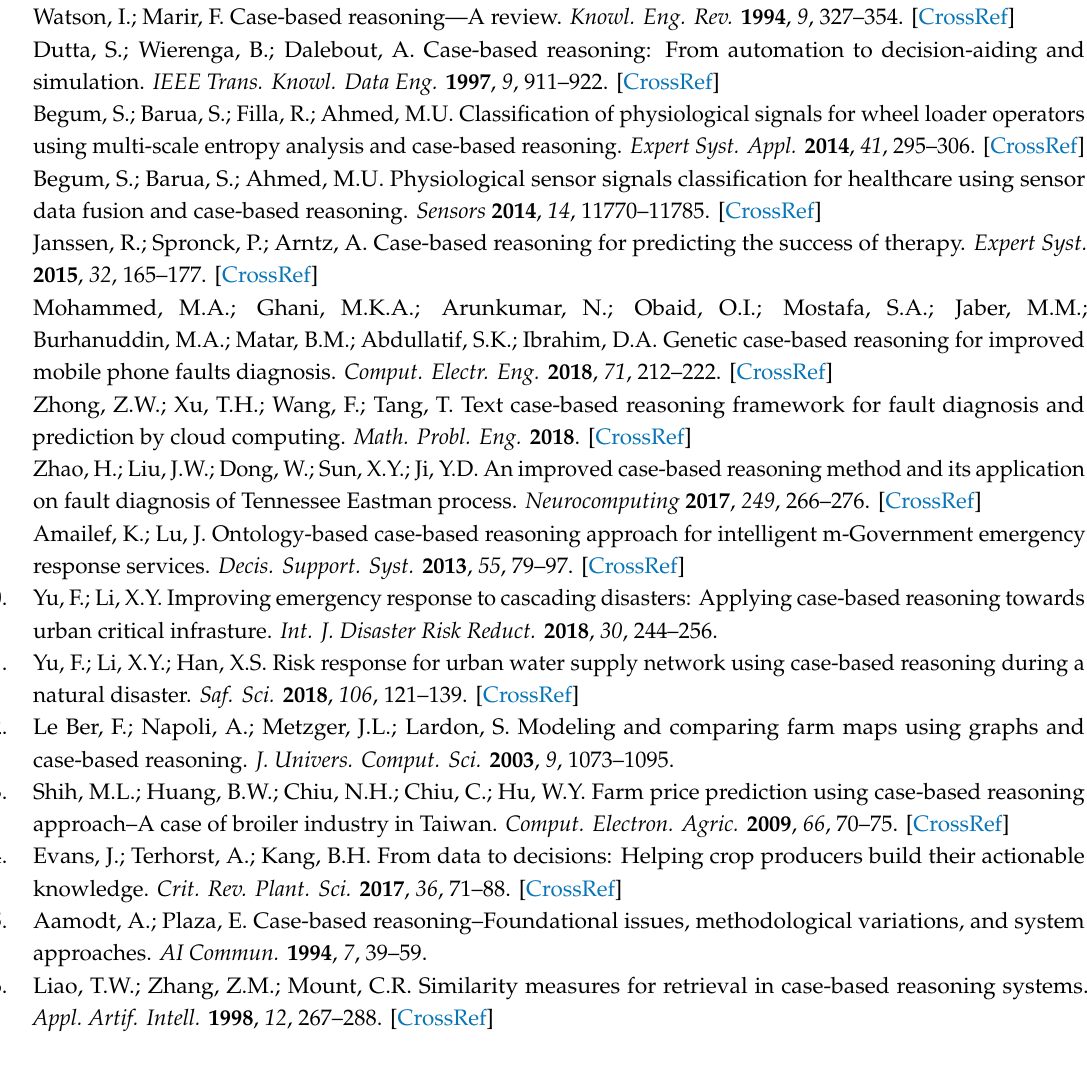
Figure A10. Attribute visualization of new case 155 and retrieved past case 672.